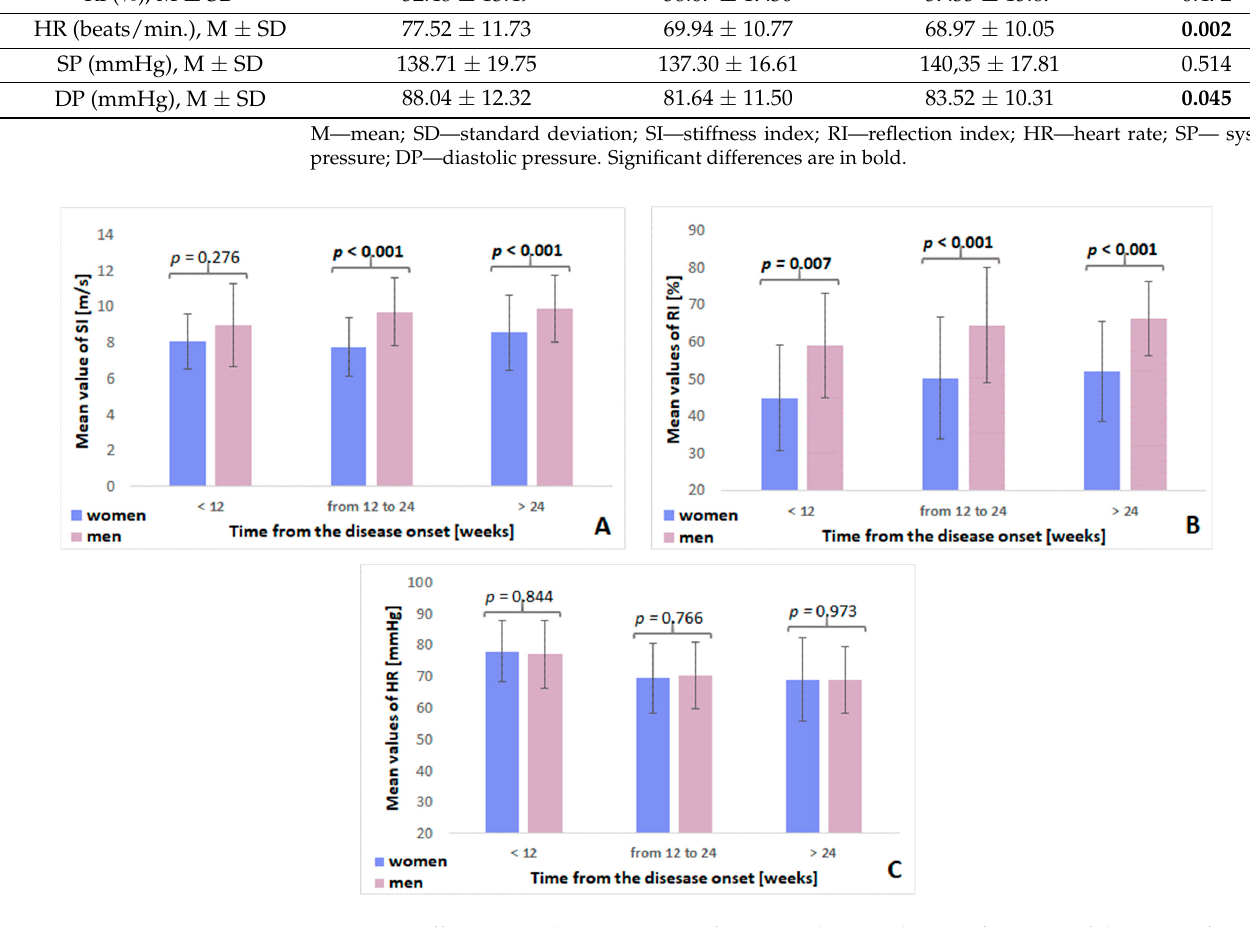
Figure 2. Differences in the parameters of SI, RI, and HR in the specific stages of the onset of COVID- 19 based on sex (( A )—differences in SI parameter; ( B )—differences in RI parameter; ( C )—differences in HR). Significant differences are in bold.